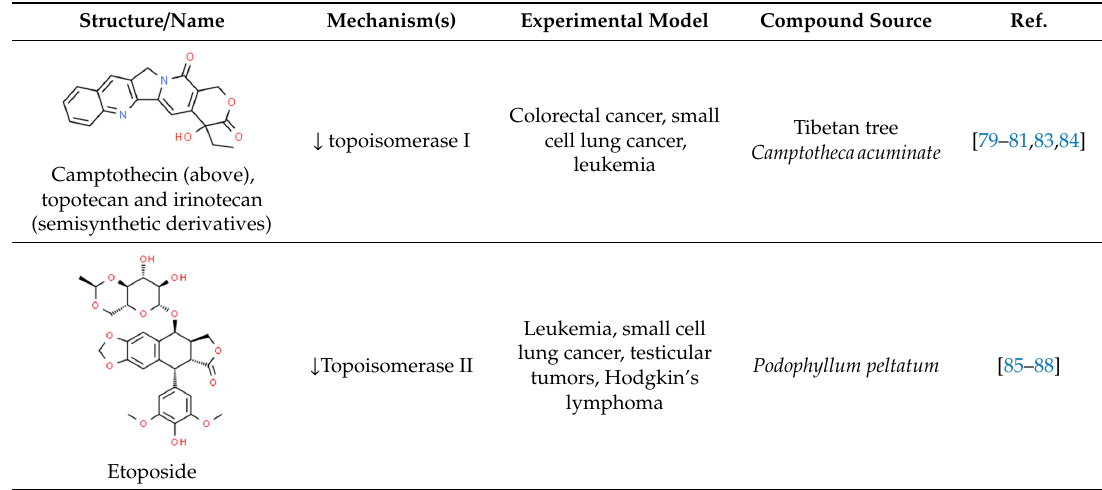
Table 2. Topoisomerases inhibitors—a brief summary. Images of the chemical structures